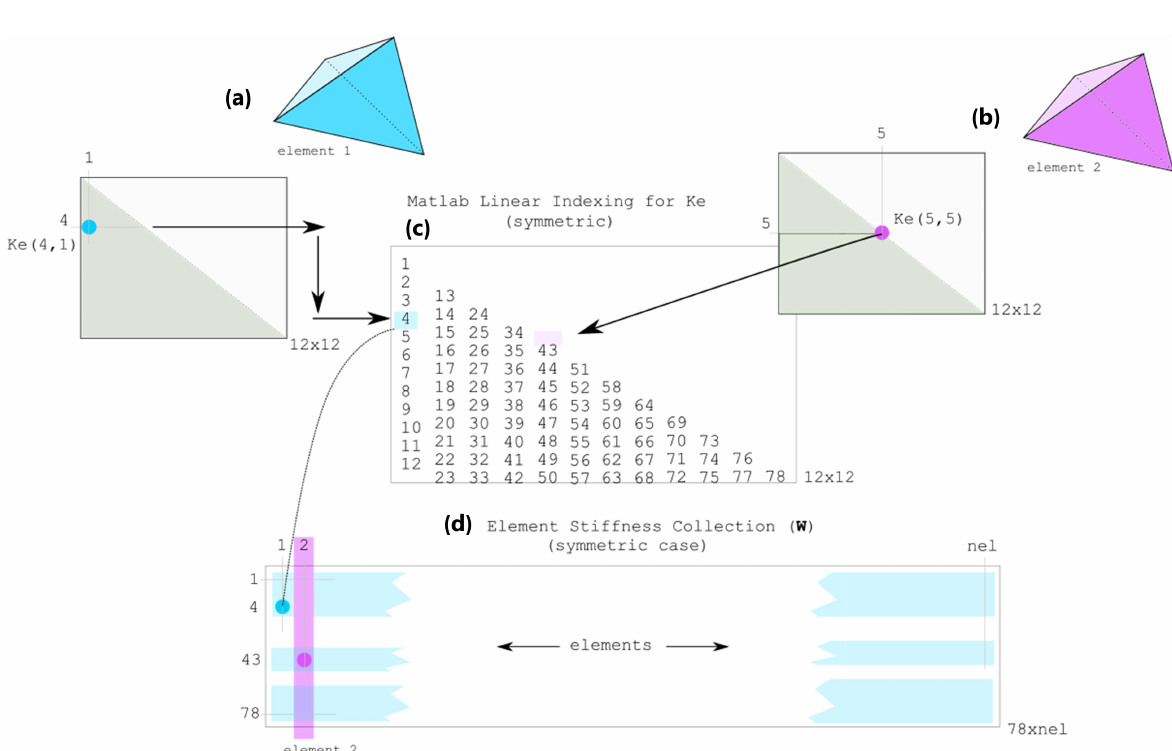
Figure 5. Linear indexing and idea of the method for allocation of terms from the explicit matrix (symmetry case). (a) element 1; (b) element 2; (c) lower triangular indices; (d) final collection with arrays of